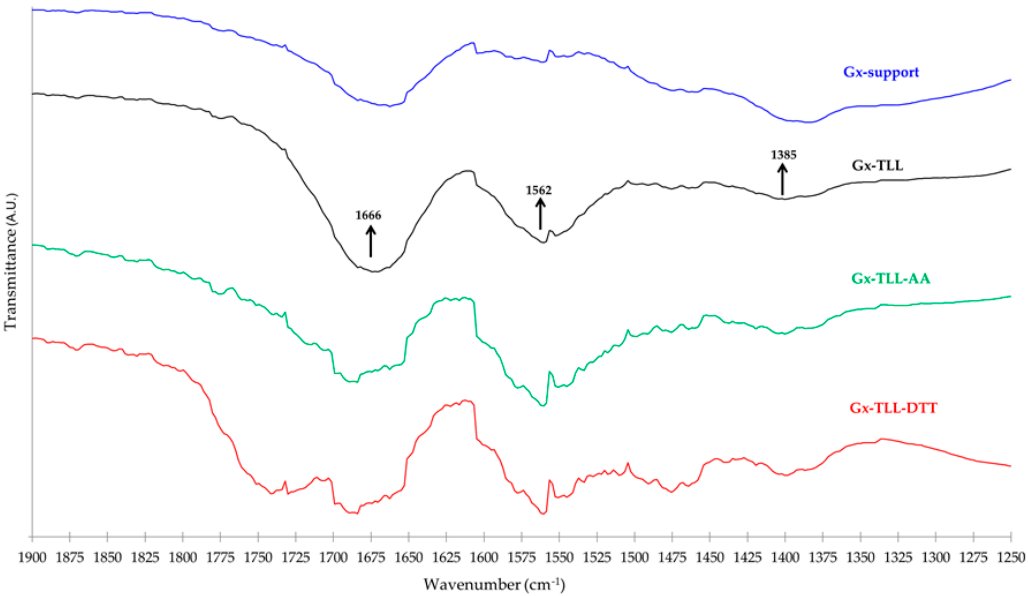
Figure 5. FTIR-ATR transmittance spectra within the distinctive region. Gx support without modifications (blue) and Gx biocatalysts resulting from the immobilization of TLL: at conventional pH 10 (black), in presence of 20 mM AA at pH 7.0 (green), or in presence of 20 mM DTT at pH 7.0 (red).